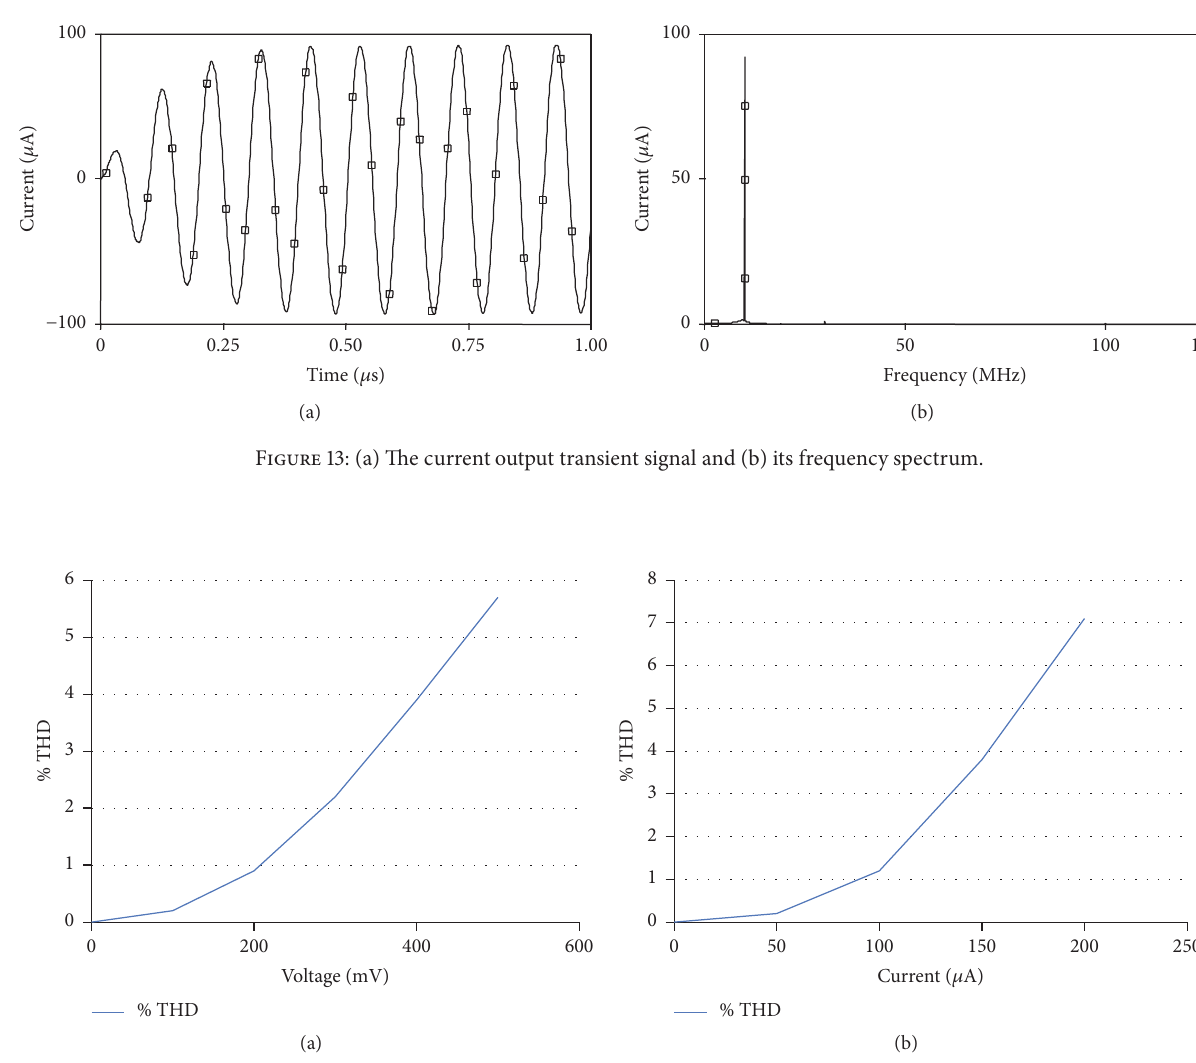
Figure 14: THD variation of BP filter against amplitude of the applied sinusoidal signal at 159 KHz (a) voltage mode and (b) current